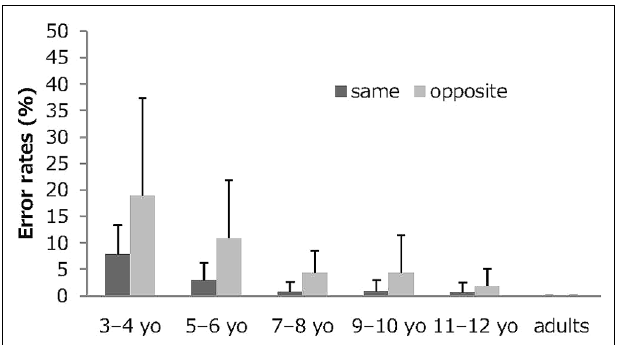
FIGURE 1 | Mean error rates in the Stroop-like big–small. Error bars represent standard deviations. No adults showed an